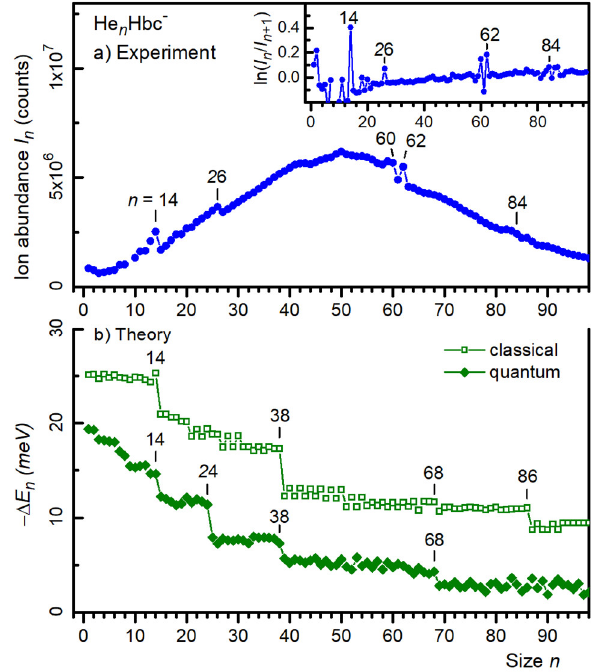
Figure 3. ( a ) Ion abundance I n of He n Hbc − anions versus size n . The insert displays the negative first derivative of the logarithmic ion abundance. ( b ) The first derivative of the energy − E n of He n Hbc − calculated from the classical global minima and the quantum virial energy (open squares and filled diamonds, respectively).